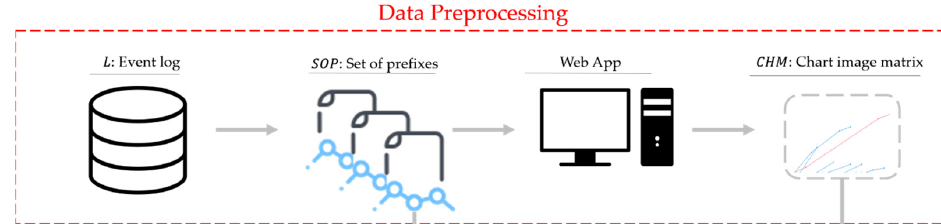
Figure 1. The general framework of the proposed deep-learning model.